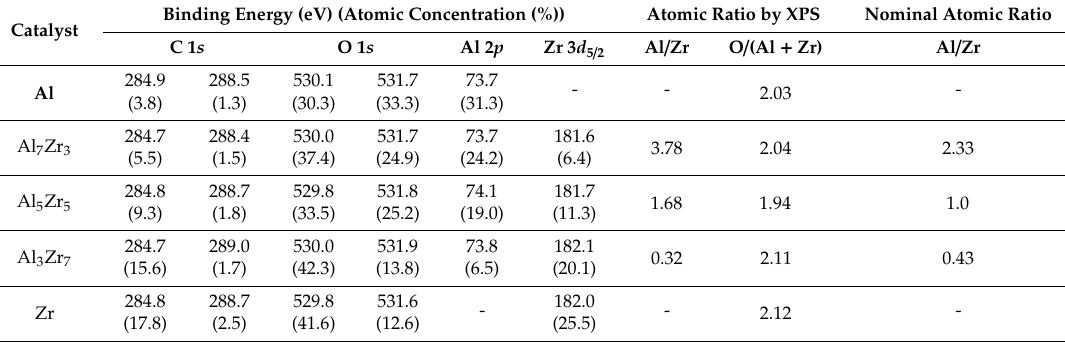
Table 2. Atomic ratios and binding energies found in XPS analysis for Al, Zr, and Al x Zr y catalysts.